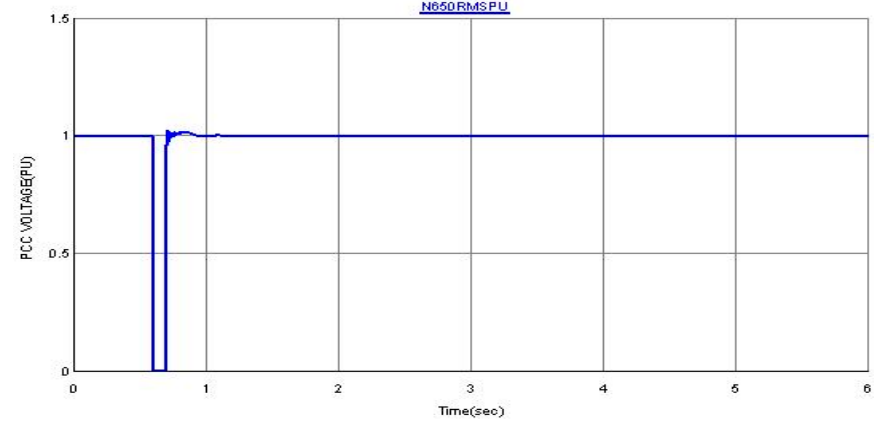
Figure 19. PCC pu voltage during grid fault.